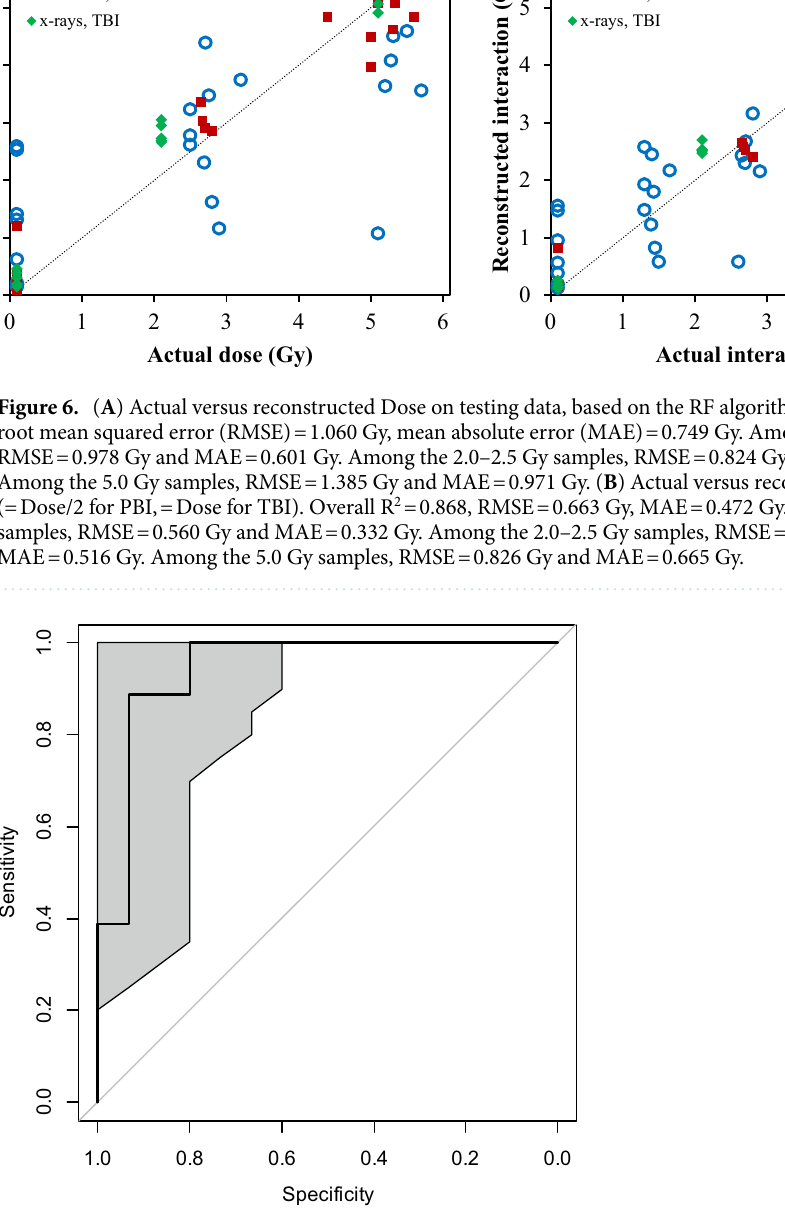
Figure 7. Discrimination between PBI and TBI exposures by the RF algorithm among irradiated samples in the testing data set. We used predicted Dose—predicted Interaction to predict TBI versus PBI status for each irradiated sample. The ROC curve AUC for this analysis = 0.944 (95% CI: 0.844–1.0). The grey shaded areas represent 95% confidence regions estimated by 10,000 bootstrap replicates. The diagonal black lines represent random classification